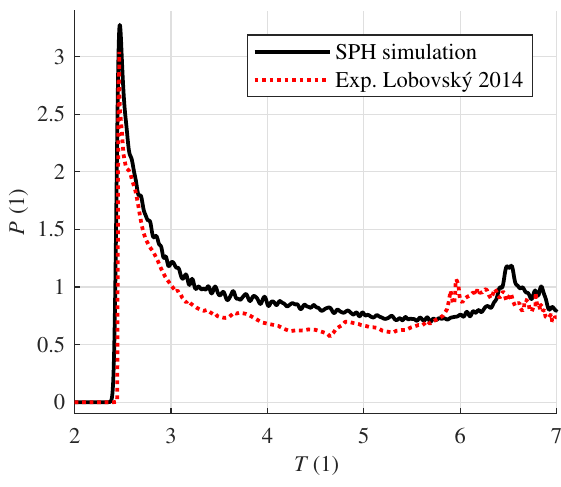
Fig. 12. Non-dimensional pressure as a function of non- dimensional time at sensor P3. Exp. Lobovský 2014 [2].